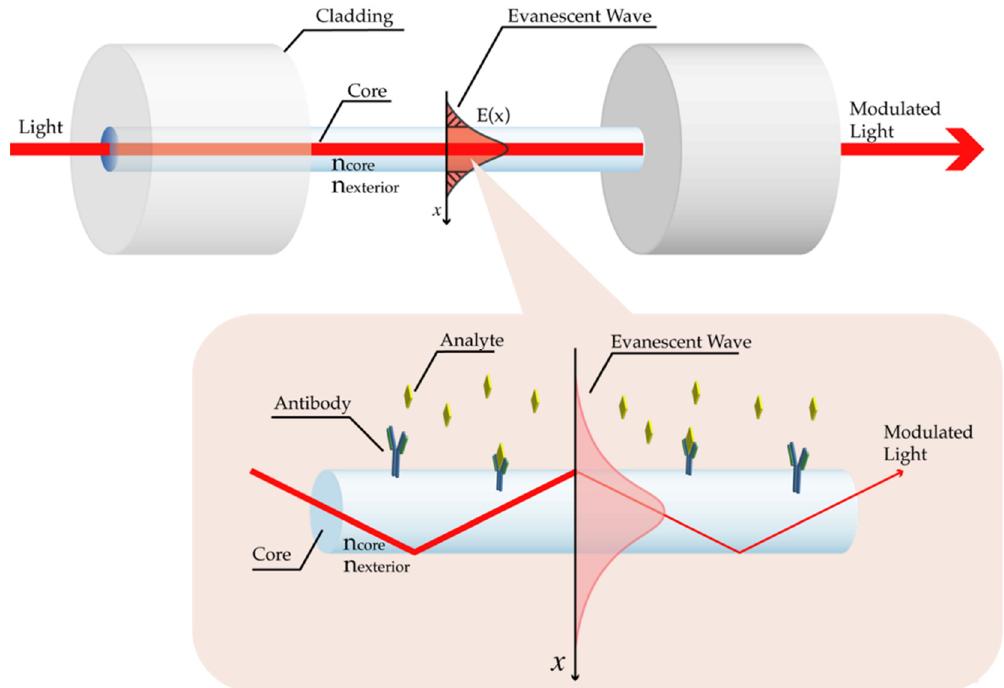
Figure 2. Schematic illustration of the TIR phenomenon in an uncladded optical fiber, with the resulting EW representing the EW reaching of the AB analyte interaction and consequent modulation of optical signal by the surrounding RI change.